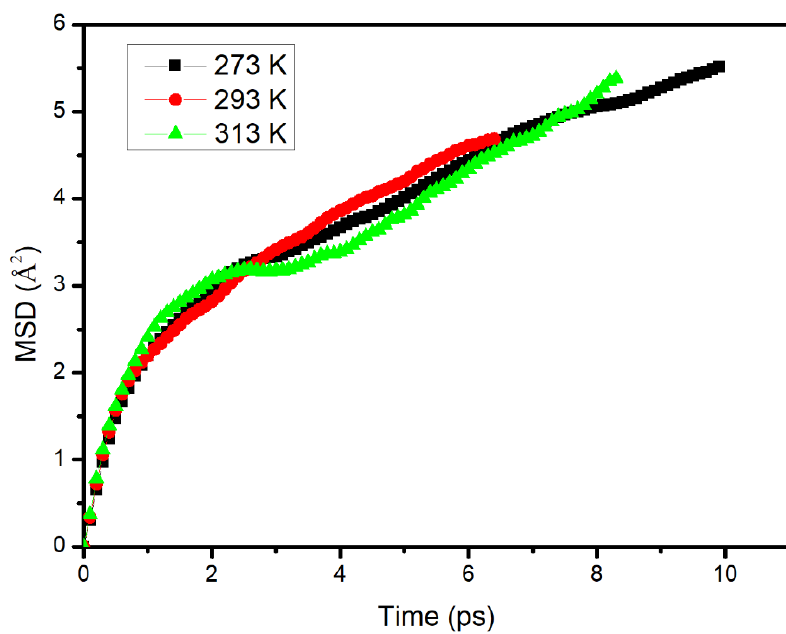
Figure 18. Change in the mean square displacement over time of sunflower oil in the asphalt. The diffusion coefficient was calculated based on the linear fitting of the second stage, where the result is shown in Figure 19. It can be found that the fitting slopes of the second stage at 0 °C, 20 °C, and 40 °C were 0.3261, 0.4161, and 0.4552, respectively. The diffusion coefficients of S in the asphalt at 0 °C, 20 °C, and 40 °C were 5.43 × 10 − 10 m 2 /s, 6.934 × 10 − 10 m 2 /s, and 7.587 × 10 − 10 m 2 /s, respectively. With the increase of temperature, the diffusion coefficient of S in the asphalt gradually increased. Molecular motion needs energy. The higher the temperature, the greater the molecular energy. The asphalt molecules had better diffusion ability.